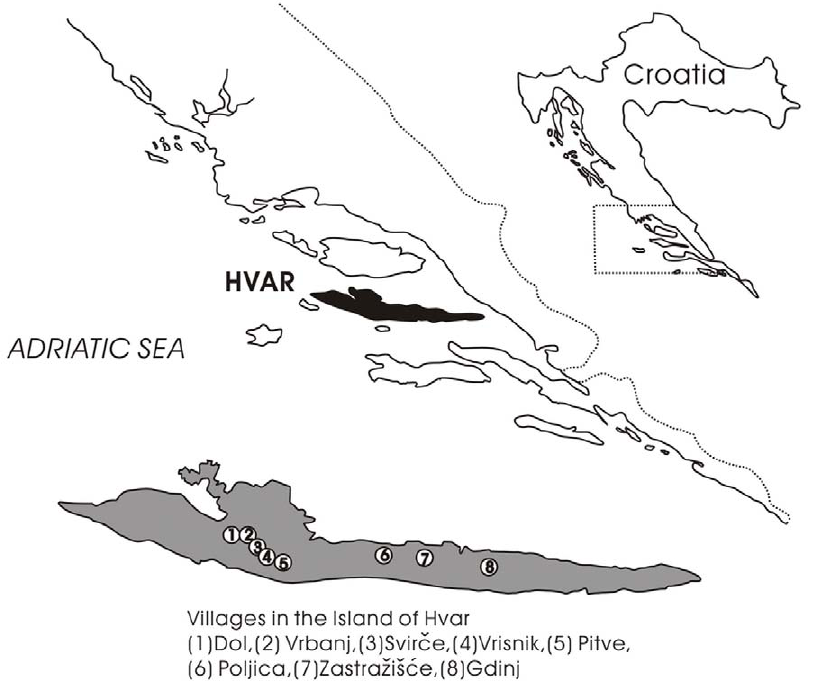
Figure 1. Geographical location of Hvar and the 8 villages from where the samples were collected.